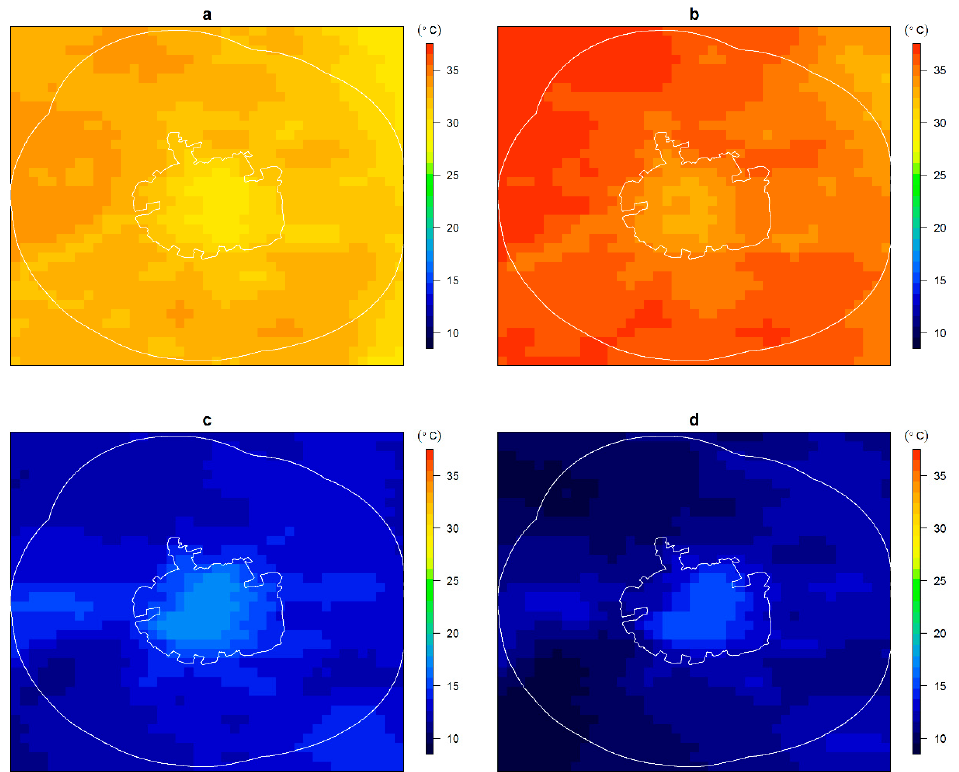
Figure 2. Average Land Surface Temperature of the city and the rural areas from MODIS Aqua and Terra for both day and night-time passes over 12 years, from 2003 to 2014. ( a ) 11:00; ( b ) 13:00; ( c ) 22:00; ( d ) 2:00.